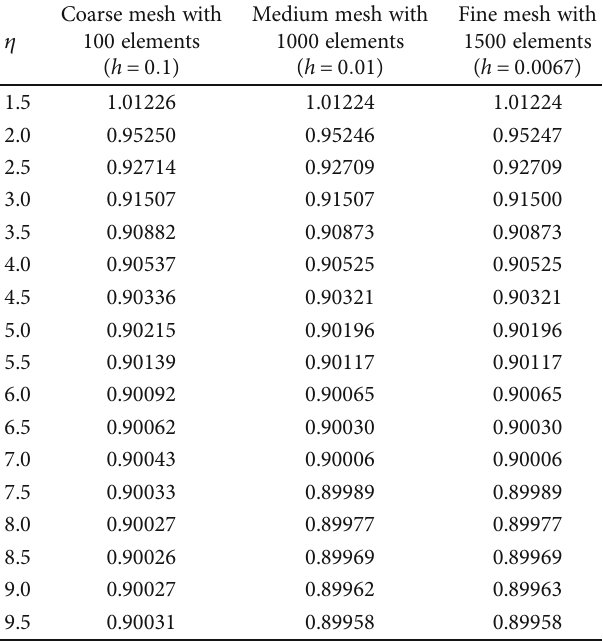
Table 1: Grid-independence test for velocity distributions j f ′′ ð η Þj .